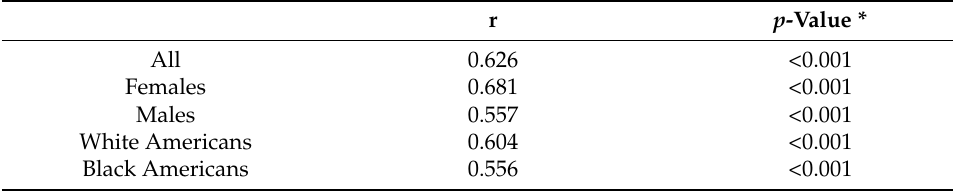
Figure 10. Association between known-age-at-death (in years) and AMTL frequency. Table 7. Results of Spearman’s correlation tests between age-at-death and